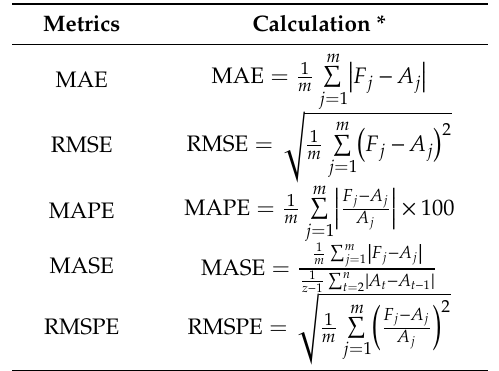
Table 1. The equations of the five performance